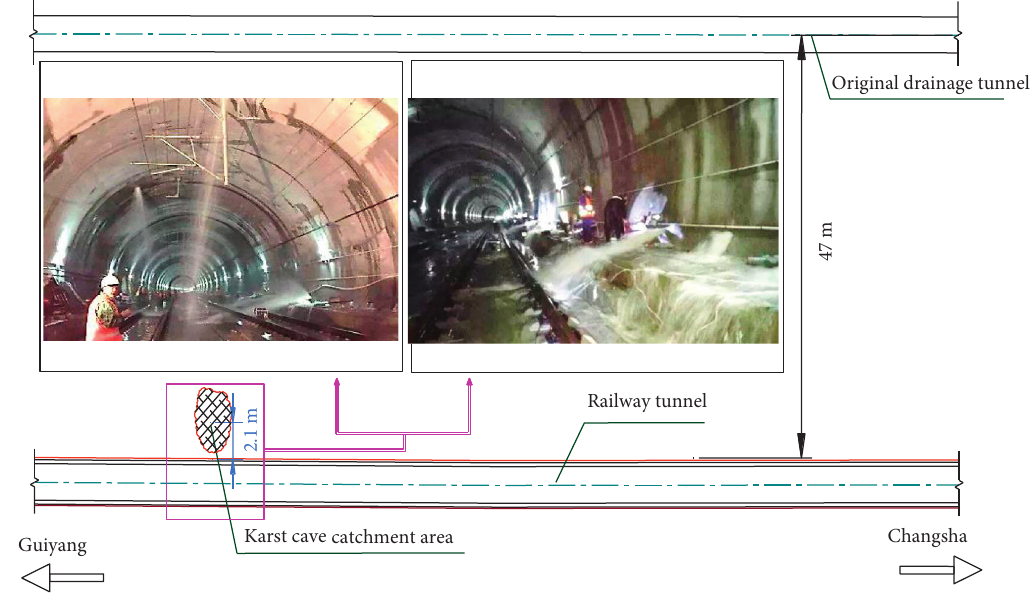
Figure 5: Water gushing from tunnel lining.